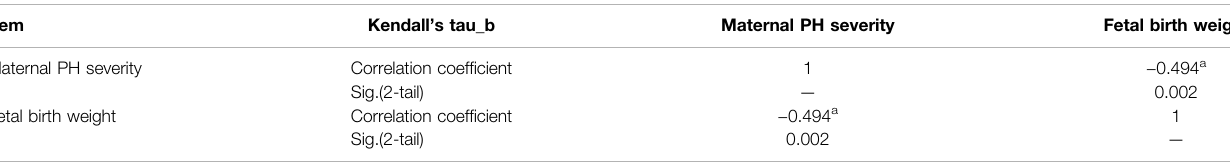
a Correlation is signi fi cant at the 0.01 level (2-tailed).